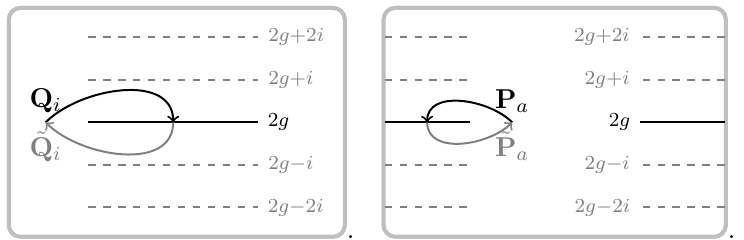
Figure 2. Branch cut structure of the QSC for the Hagedorn temperature. There exists a Riemann sheet for which Q i has a single ‘short’ cut and P a has a single ‘long’ cut. (Note that the branch-cut structure is the opposite of the one occurring for the spectral